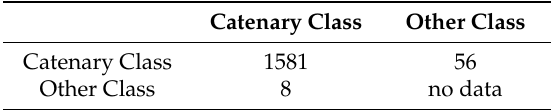
Table 8. Confusion matrix for the complete classification of detected support structures.